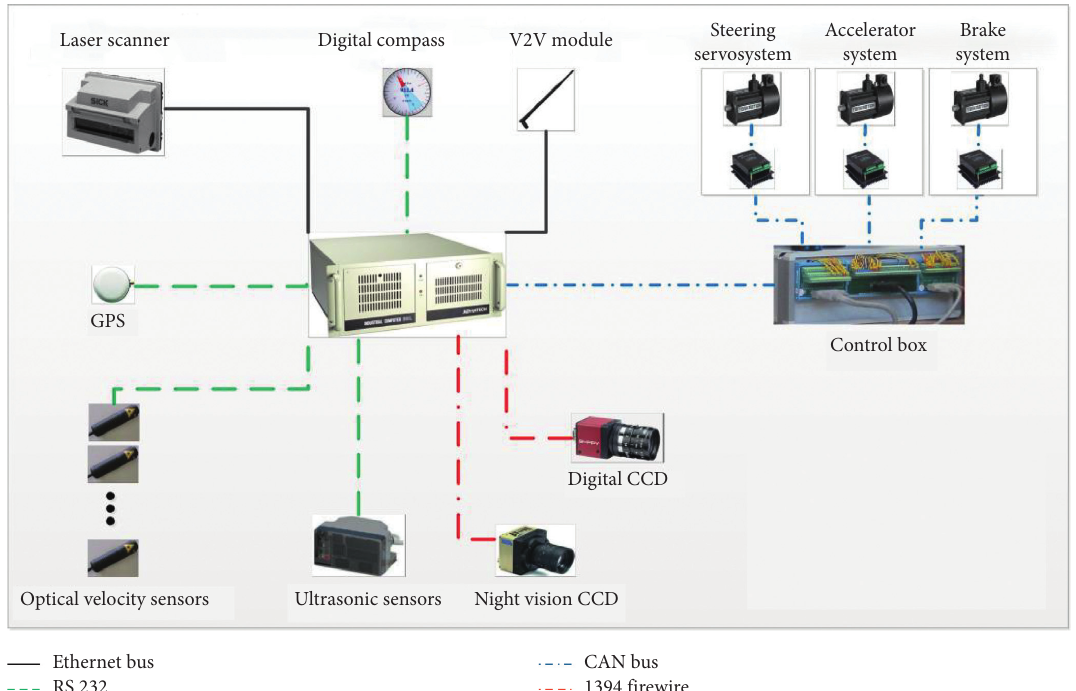
Figure 14: Sensors, computer system, and communication system in the DLU-IV for Cooperative Vehicle Infrastructure System: a case for Internet of Things principle.